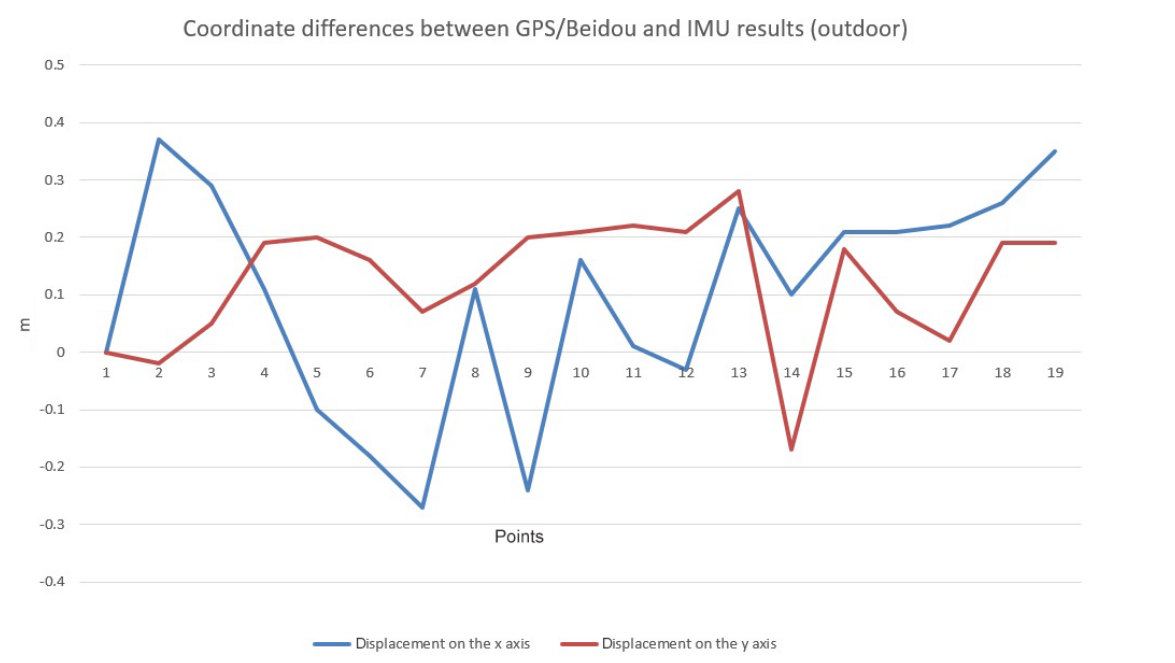
Figure 6. Coordinate differences between GPS/Beidou and MTi-IMU results (outdoor environment).